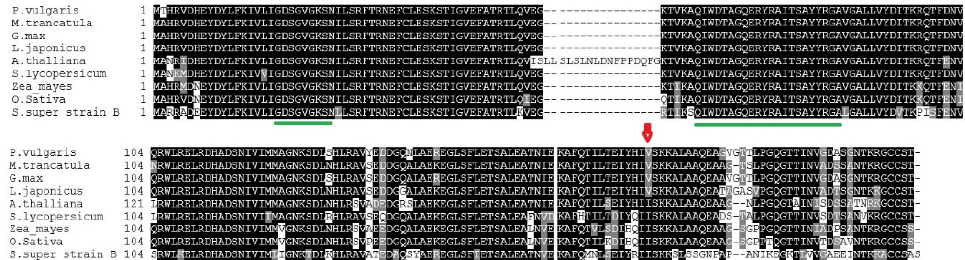
Figure 2. Multiple sequence alignments and the proteins of S. lycopersicum super strain B (RABA2) and those retrieved from the genomic databases: A. thaliana (At1g07410, O. sativa (LOC_Os03g60870), S. lycopersicum (Solyc06g076450), Z. mays (GRMZM2G473906), L. japonicus (chr3.CM0792.300.r2.d), M. truncatula (Medtr4g064897), P. vulgaris (Phvul.011G061100), and G. max (Glyma11g14360). Black boxes represent the identical residues while gray ones represent conservative substitutions. Align- ments were performed with Clustal Omega in MEGA7 followed with Boxshade. The red arrow designates a conservative amino acid substitution in legume against non-legume sequences. The conserved domains of Rabs are indicated by green lines.